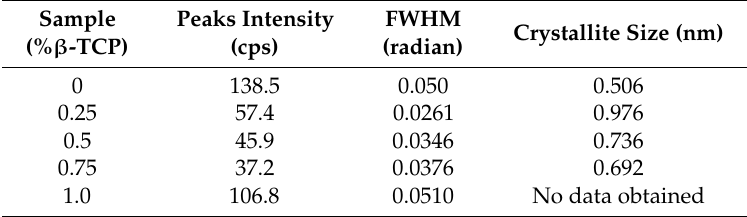
Table 2. In crystallite size with the increasing concentration of the β -TCP in the composition. Sample Peaks Intensity (% β -TCP)